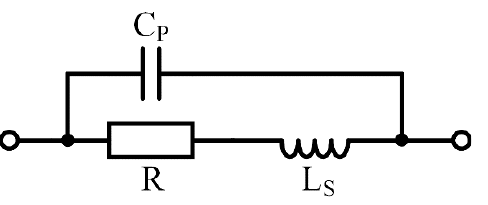
Figure 2. Basic equivalent circuit of a physical resistor accounting for most parasitic effects.